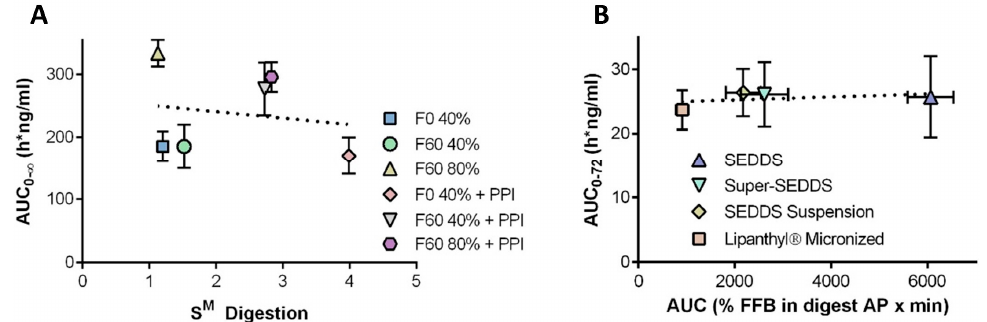
Figure 7. IVIVC of drug absorption and in vitro supersaturation (S) during digestion calculated using the method proposed by Anby et al. [52]; ( A ) Supersaturation ratio (S) in digestion AP plotted against the AUC of the plasma vs. time profiles after administration of four danazol containing MCT LBF formulations to male beagle dogs. PPI = polymeric precipitation inhibitor. Data replotted from [52]. ( B ) In vitro in vivo correlation of drug absorption and in vitro digestion data. ( B ) AUC of the percentage of fenofibrate in digestion apparent solubility plotted against the AUC of the plasma vs. time profiles after administration of three LBF formulations and one encapsulated crystalline formulation (Lipanthyl ® Micronized) to Göttingen Minipigs, (R 2 = 0.12). Data were digitized and AUCs calculated as previously described and data replotted from [194]. Reprinted from [18] with permission (Elsevier 2016).